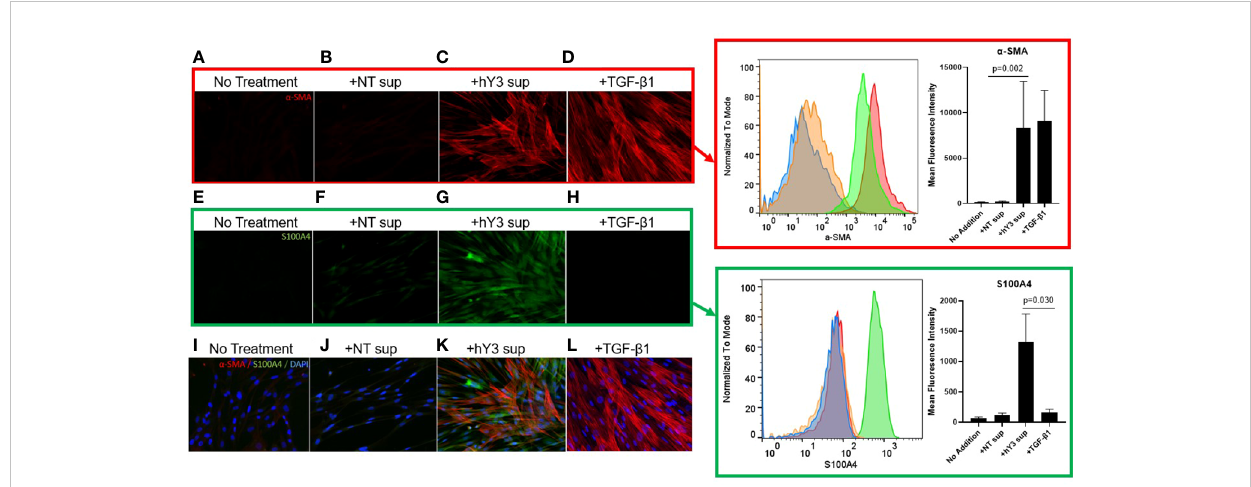
FIGURE 3 Differential effects of hY3-generated macrophage supernatants and TGF- b 1 on fetal cardiac fi broblast expression of a -SMA and S100A4. Fibroblasts isolated from healthy fetal hearts were incubated with the supernatants of hY3-transfected macrophages (hY3 sup) for 72 hours or the direct addition of activated TGF- b 1 and stained for a -SMA (red), S100A4 (green), and DAPI (blue), 20x magni fi cation. Minimal staining for either a -SMA or S100A4 was observed in untreated fi broblasts (A, E, I) or with the addition of supernatants from vehicle alone (DOTAP) macrophages (B, F, J) . Incubation with hY3 sup (C, G, K) results in dual staining. Incubation with TGF- b 1 results only in a -SMA expression (D, H, L) . Inset panels (right) show an authentication of immuno fl uorescence staining with fl ow cytometry. Flow panel (red box) shows untreated fi broblasts (blue histogram), like those incubated with NT sup (orange histogram), express negligible a -SMA. In contrast, fi broblasts cultured with hY3 sup (green histogram) or TGF- b 1 (red histogram) exhibited a three-log-fold positive shift in a -SMA expression after 72 hours. Flow panel (green box) shows that exposure to hY3 sup resulted in the fi broblast expression of S100A4 (green histogram) while none of treatments including TGF- b 1, shared this property. Quanti fi cation (mean fl uorescence intensity) of each condition is shown in the bar graphs within the red and green boxes and represents the average of each condition over four fl ow cytometry experiments. Bars represent mean ±